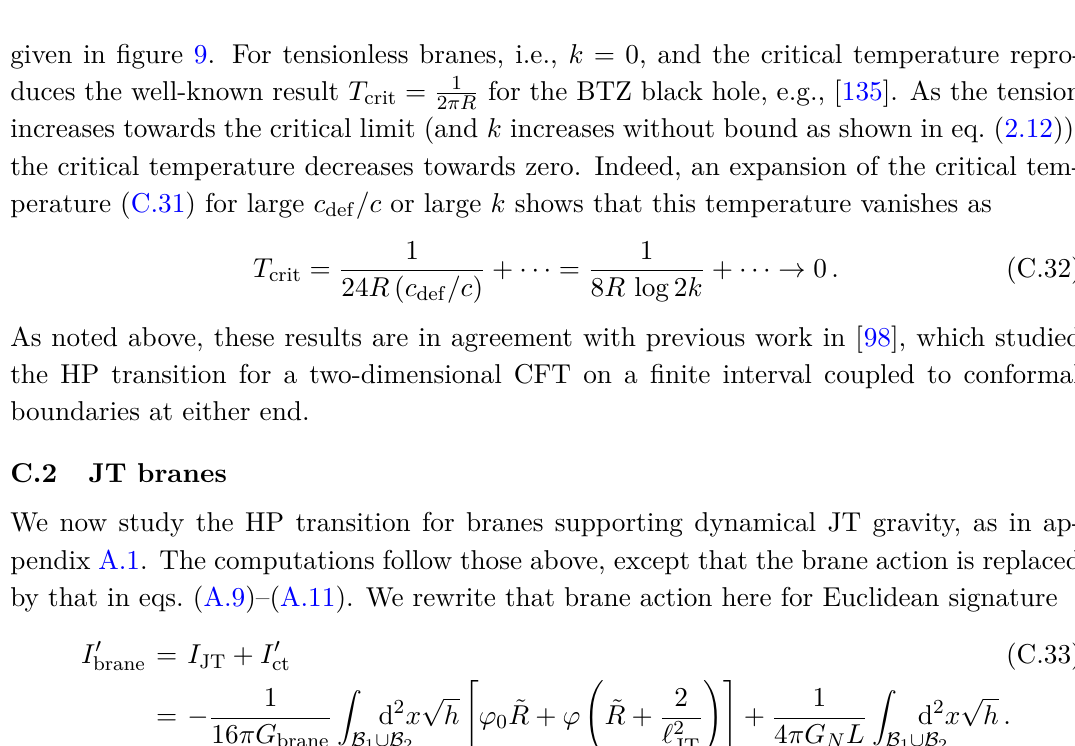
Figure 9 . Plot of 2 πRT crit versus k . The curve intersects the vertical axis at unity, as expected for the tensionless limit. For large tensions, the critical temperature tends to zero, as shown in eq.